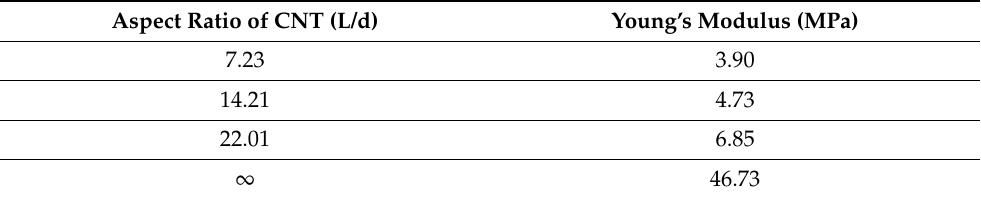
Table 5. Young’s modulus of polymethyl methacrylate (PMMA) reinforced with (5, 5)